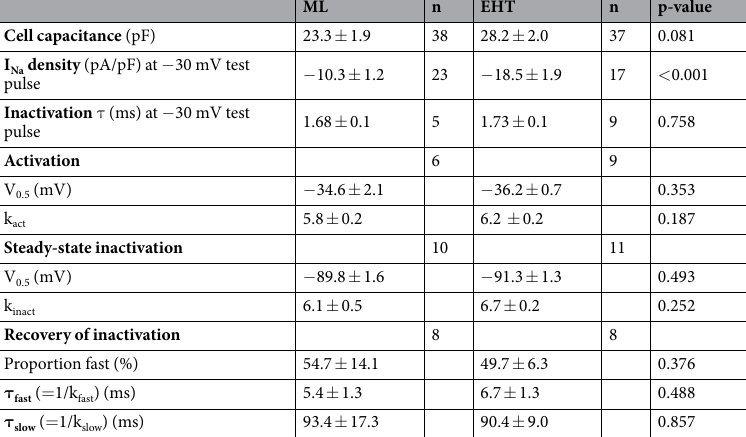
V 0.5inact or k inact (Table 1). A Boltzmann curve (Fig. 2C) showed that activation and steady-state inactivation curves overlap between ~ − 77 mV and ~ − 45 mV (inset Fig. 2C). The maximal overlap was reached at − 61.9 mV (ML) and − 61.3 mV (EHT), where normalised I Na availability and conductance were 1.4% (EHT) and 1.8% (ML) of the maximum. EHT and ML did not differ in window current amplitude or in voltage-dependency. The refractoriness of heart muscle depends critically on the fast recovery of I Na from inactivation. The pro- portion of second I Na to first I Na was decreased by shorter interpulse duration as shown by the mean data and the two-phase exponential fit (Fig. 2D). Fitting a two-phase exponential function to the data set of each individual cell revealed no difference between EHT and ML (Table 1).